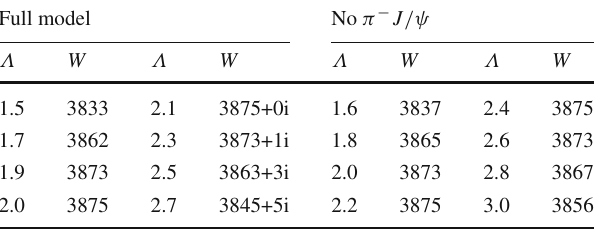
Table 1 The bound states from the π − J /ψ − D ∗− D 0 − D − D ∗ 0 inter- action with typical cutoffs Λ . The cutoff Λ and energy W are in units of GeV, and MeV, respectively